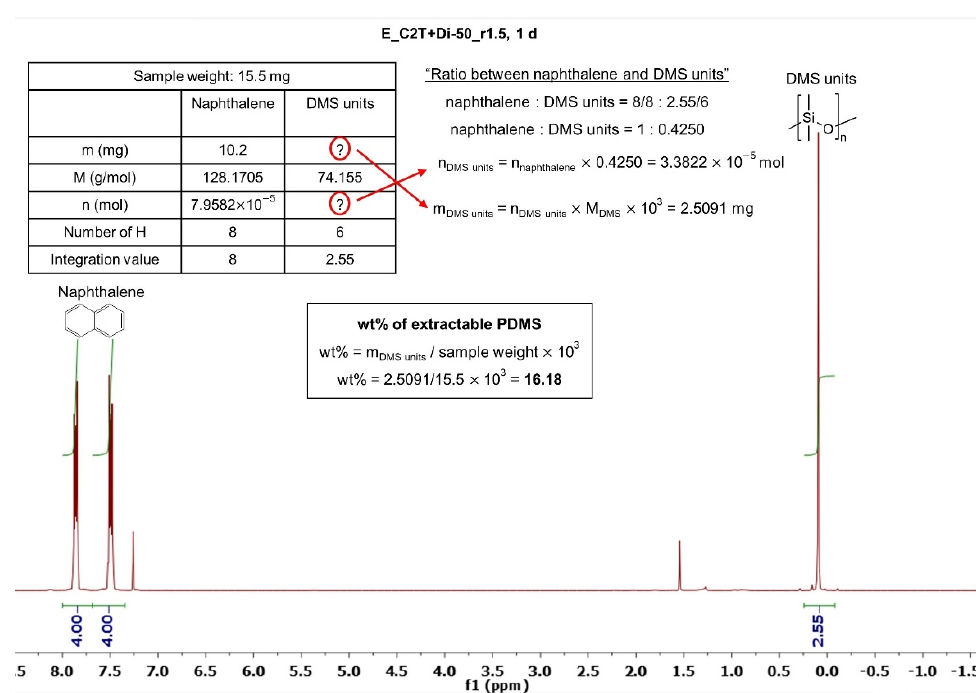
Figure A2. An example of calculation of the extractable PDMS from E_C2T+Di-50_r1.5 after 1 day in a climate chamber.